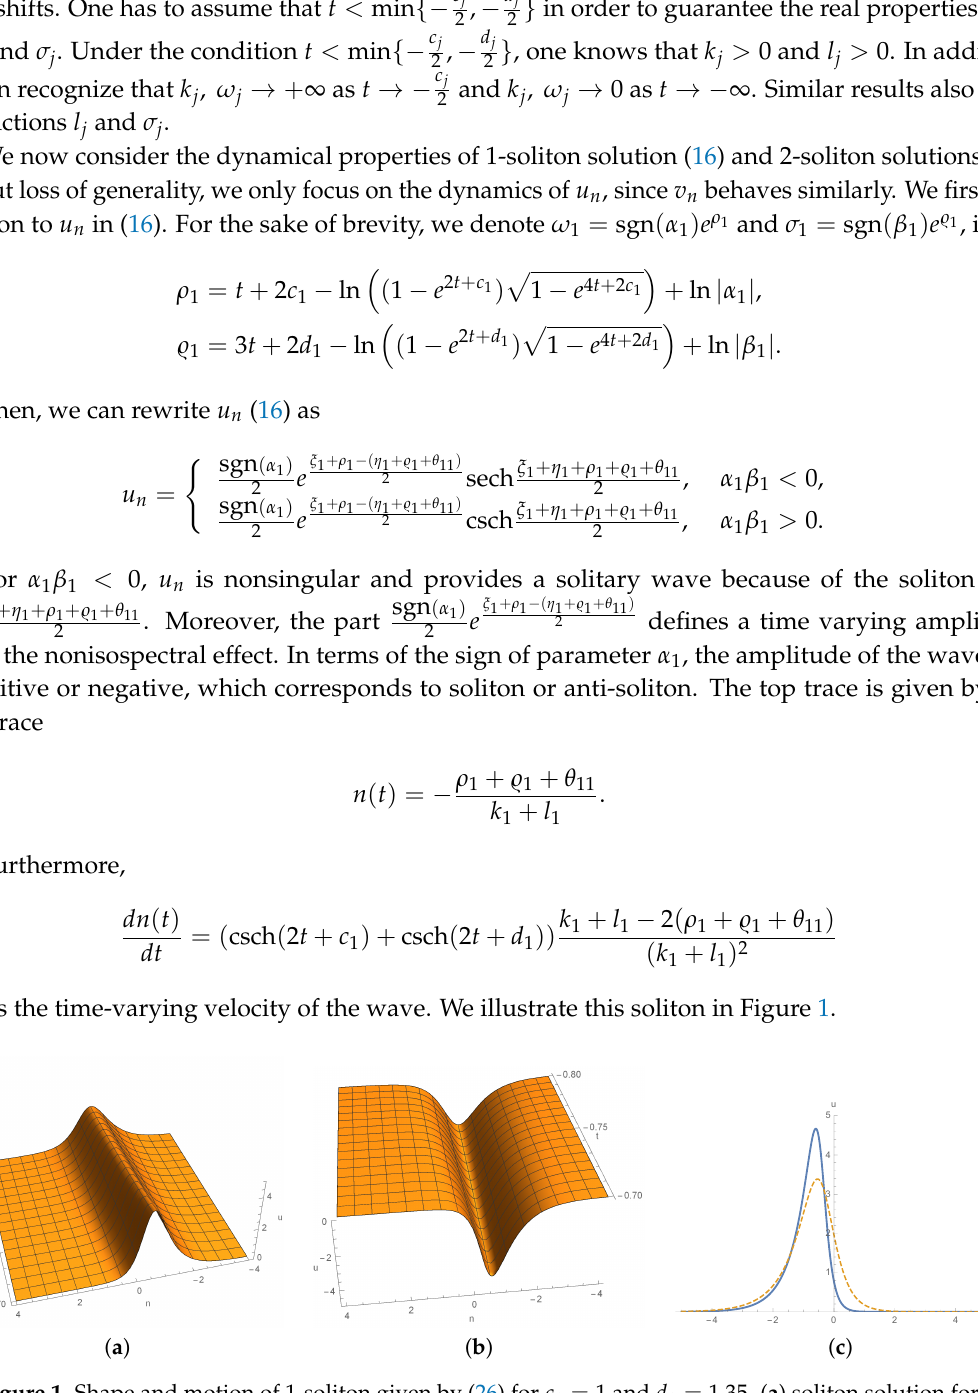
Figure 1. Shape and motion of 1-soliton given by (26) for c 1 = 1 and d 1 = 1.35. ( a ) soliton solution for α 1 = 1 and β 1 = − 1; ( b ) anti-soliton solution for α 1 = − 1 and β 1 = 1; ( c ) waves in blue (solid line) and yellow (dotted line) stand for plot ( a ) at t = − 0.68 and t = − 0.75,